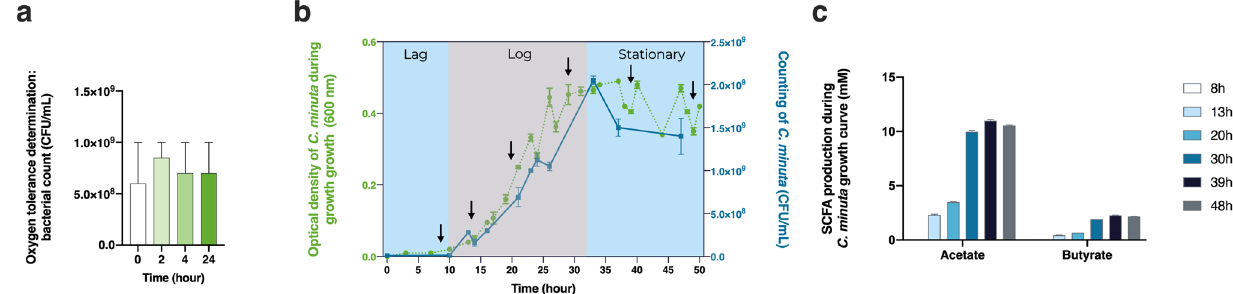
Figure 1. Oxygen sensitivity and metabolite production in Christensenella minuta . ( a ) Bacterial counts (CFUs/ mL) after 0, 2, 4, and 24 h of oxygen exposure. ( b ) Growth over time expressed in terms of optical density and colony forming units (CFUs). The arrows show the different sampling points. ( c ) Butyrate and acetate production at different sampling